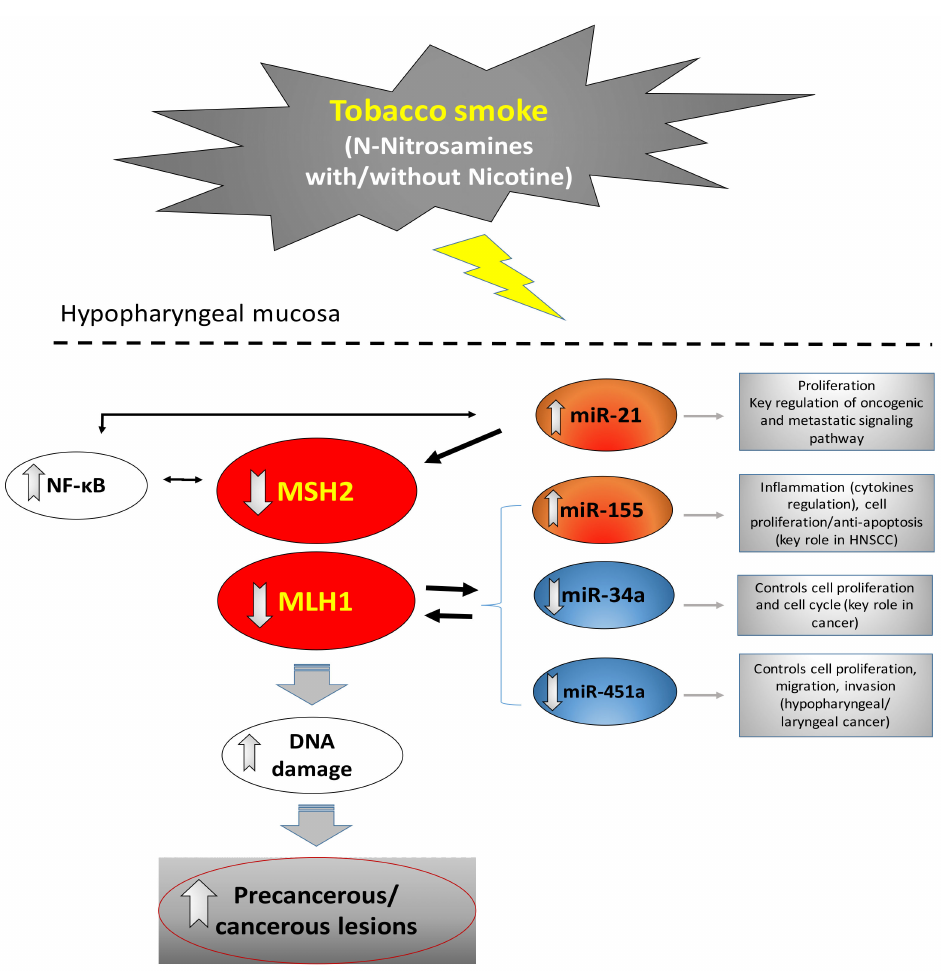
Figure 8. The in vivo chronic effect of tobacco smoke components, N -Nitrosamines, NNK and NDEA, and nicotine, induced dysregulated MMR mechanism and miRNA deregulation in carcinogenesis of the upper aerodigestive tract. MMR gene expression phenotypes are strongly linked to deregulated specific miRNAs, such as miR-21, miR-155, miR-34a and miR-451a. The activation of NF- κ B may also play a role in tobacco smoke-induced MMR dysfunction, DNA damage and carcinogenesis in the upper aerodigestive tract, interacting with miR-21 and